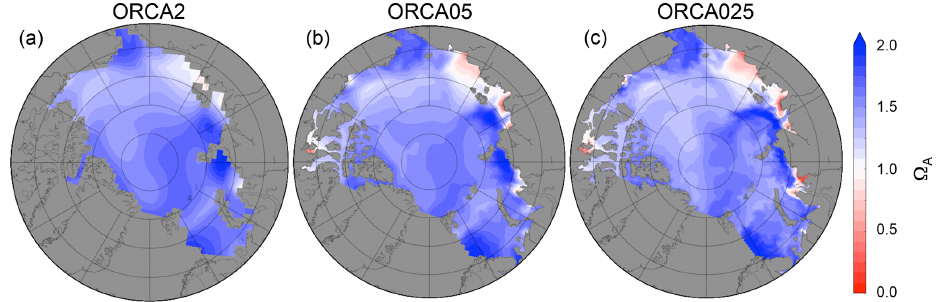
Figure 11. Surface (cid:127) A for ORCA2, ORCA05, and ORCA025 (a–c) in August